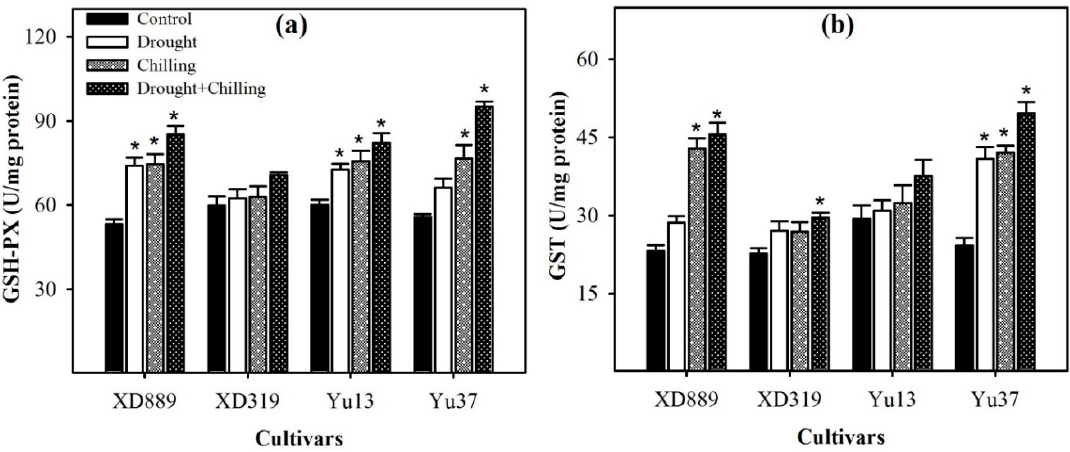
Figure 10. Activities of glutathione peroxidase ( a ) and glutathione S-transferase ( b ) in the leaves of four maize cultivars as influenced by the drought, chilling, and drought + chilling stresses. Vertical bars above mean indicate standard error of three replicates. Mean value for each treatment with * indicate significant differences by the LSD test ( P ≤ 0.05).